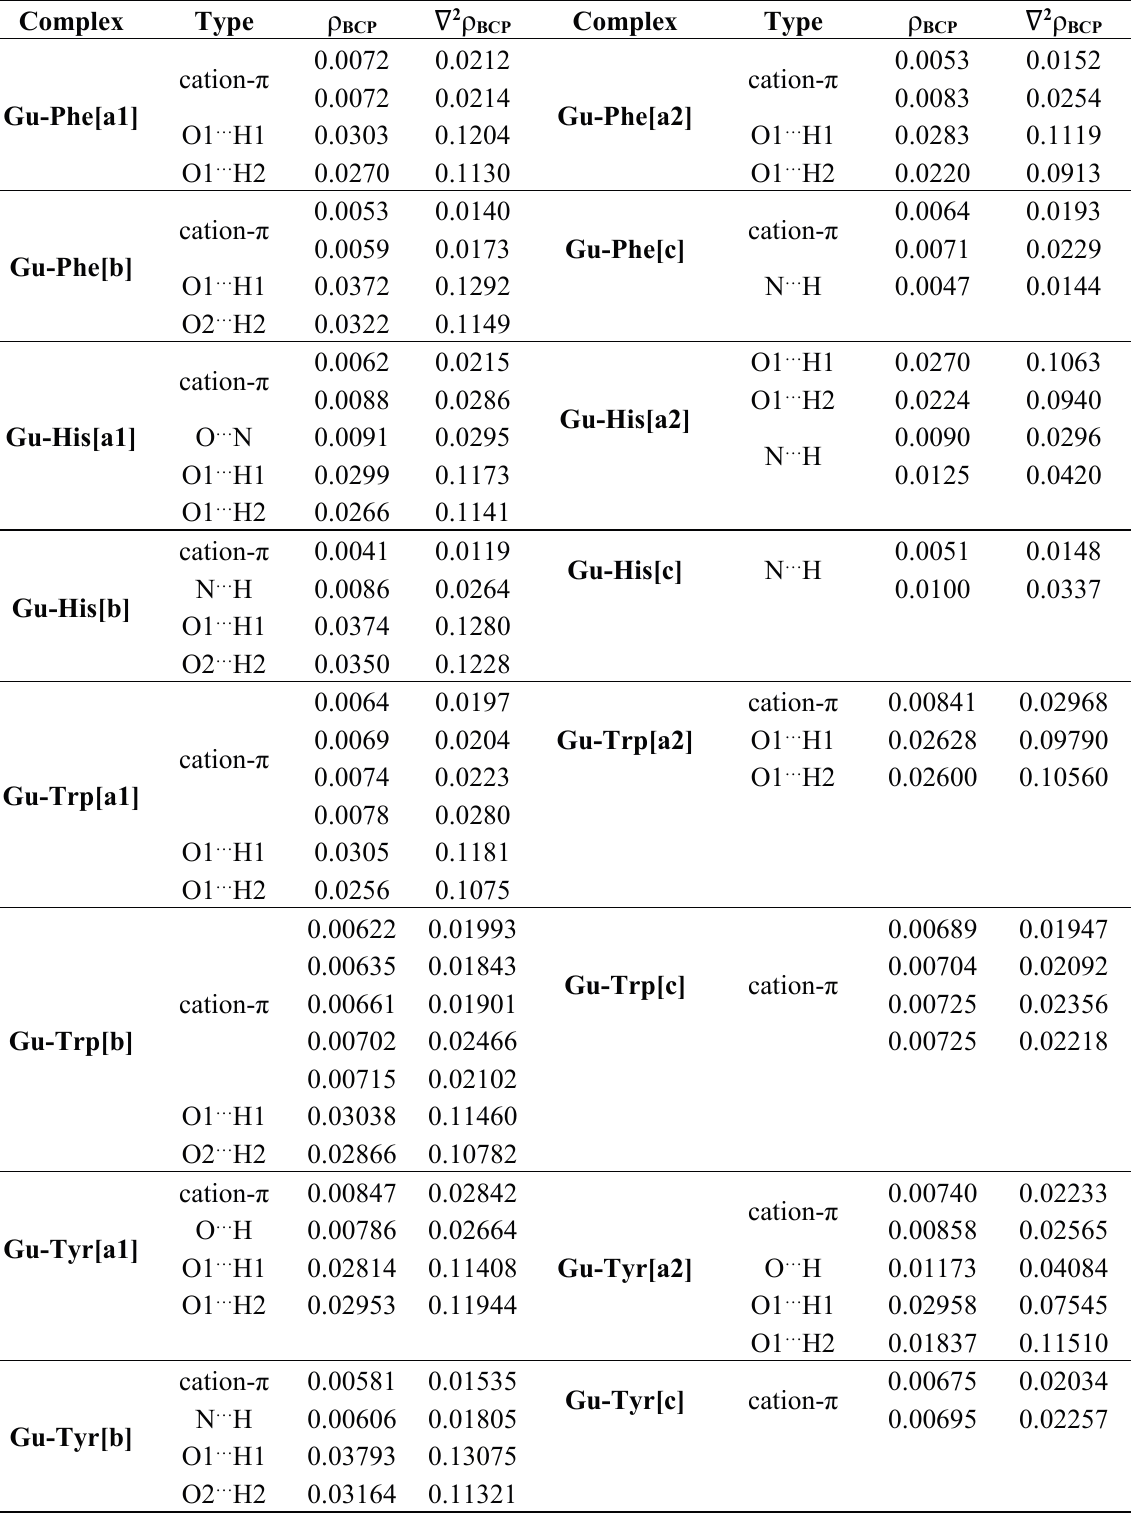
Table 2. AIM analysis (interaction type, ρ BCP and ( ∇ 2 ρ BCP , a.u.) of all the complexes studied at the M06-2X/6-311++G(d,p) computational level in PCM-water.